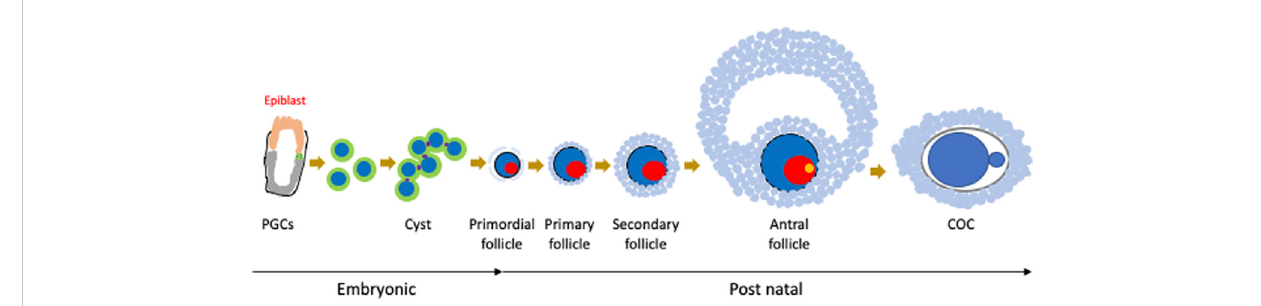
FIGURE 1 Oocyte development in mice. As the origin of oogenesis, primordial germ cells (PGCs) are speci fi ed from epiblasts, migrate to the embryonic ovary, form cysts, and enter meiosis. After birth, cysts are broken down and oocytes form follicles with granulosa cells. Follicles then mature as an enlarging oocyte mass and proliferation of granulosa cells. Finally, oocytes are ovulated as cumulus oocyte complexes (COCs).